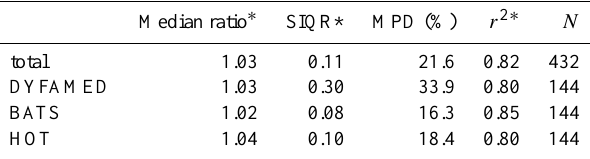
Table 6. Comparison between “satellite-corrected” Chl a C and con- comitant HPLC values after having applied a monthly average filter. See the caption of Table 3 for details about parameters.